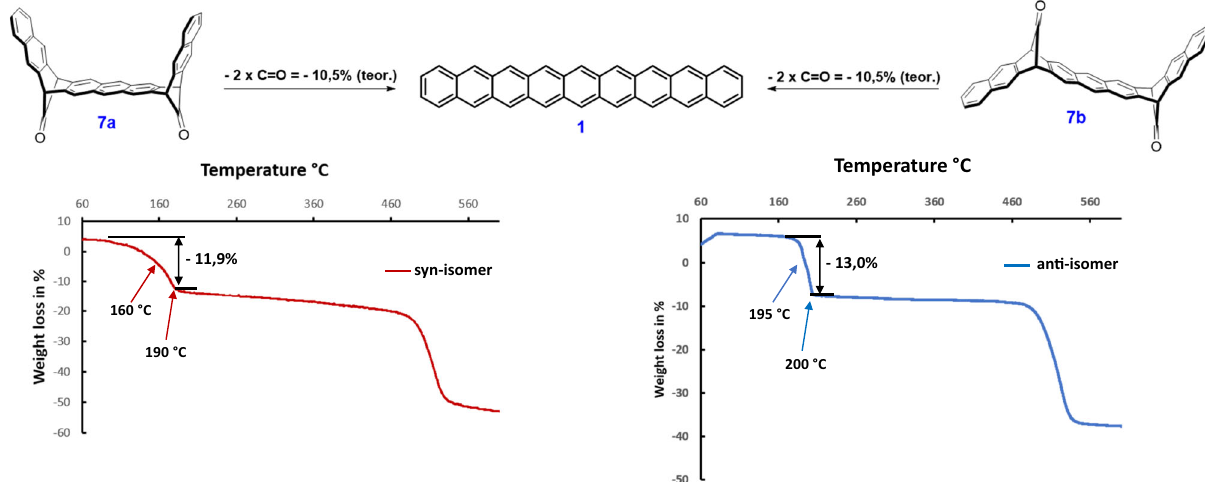
Fig. 5 TGA thermograms of 7a/7b. These curves show the weight loss of two CO groups (ca 12 and 13%; calcd. 10.5 %).